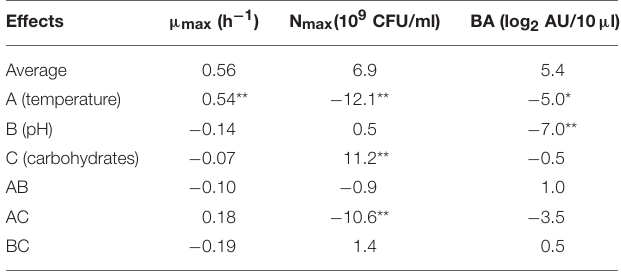
TABLE 3 | Effects of temperature, pH and carbohydrates and their interactions on the responses maximum growth rate ( µ max ), maximum bacterial count (N max ), and bacteriocin activity (BA; L. monocytogenes RF76 was used as the indicator strain).